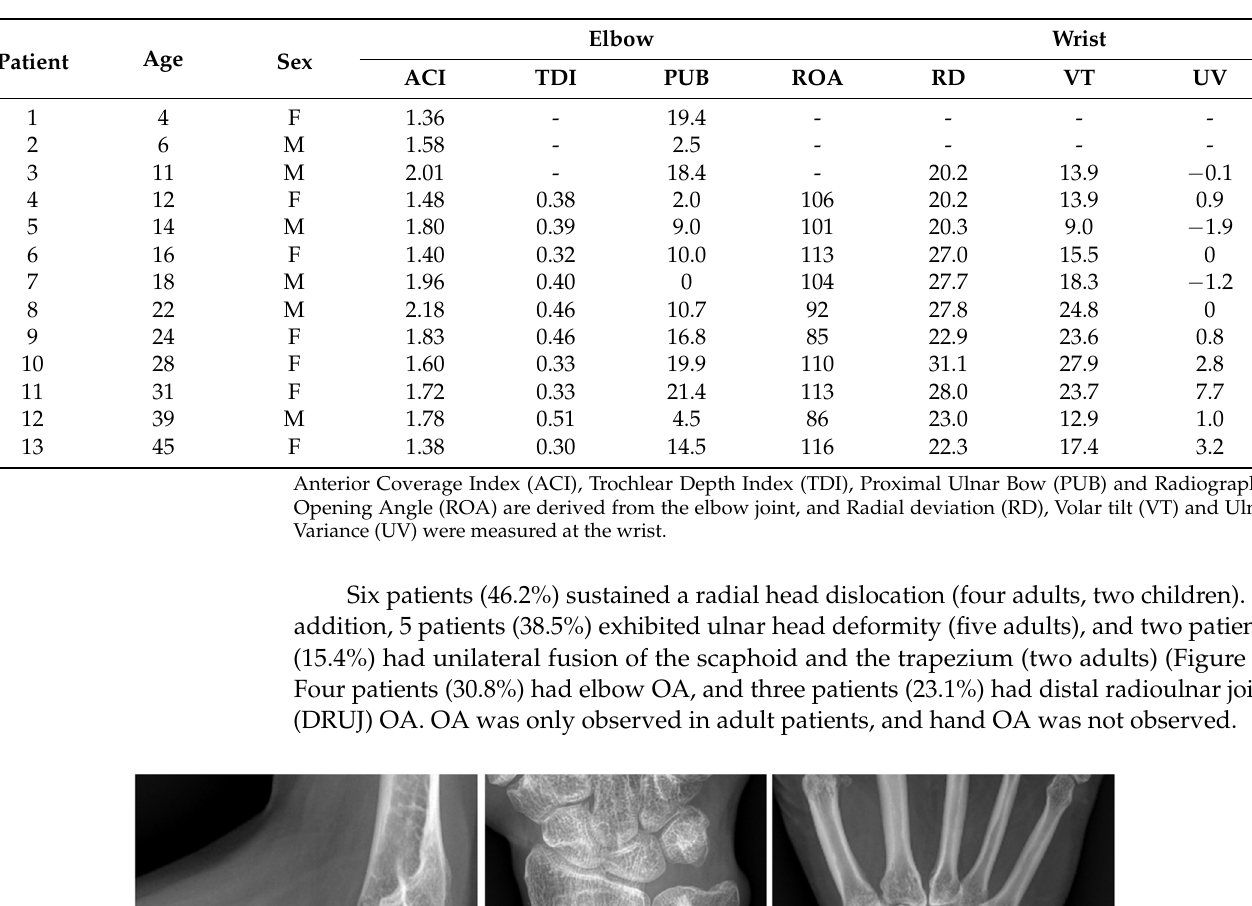
Table 3. Radiological features of patients with mcEDS.